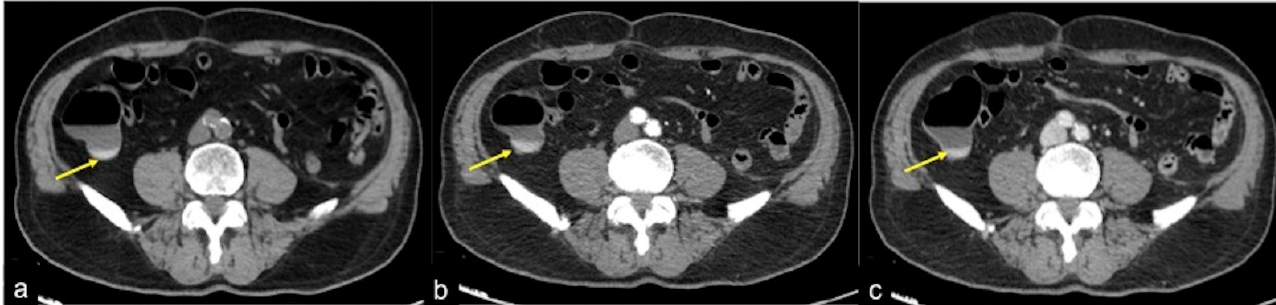
Figure 15. CTA multiphasic study of slow flow bleeding in arterial ( a ) and venous ( b ) phases. The haemorrhagic spot at the surgical site of ileo-colic anastomosis appears inconspicuous in the arte- rial phase (( a ) arrow) and is better identifiable in the venous phase (( b ) arrow).